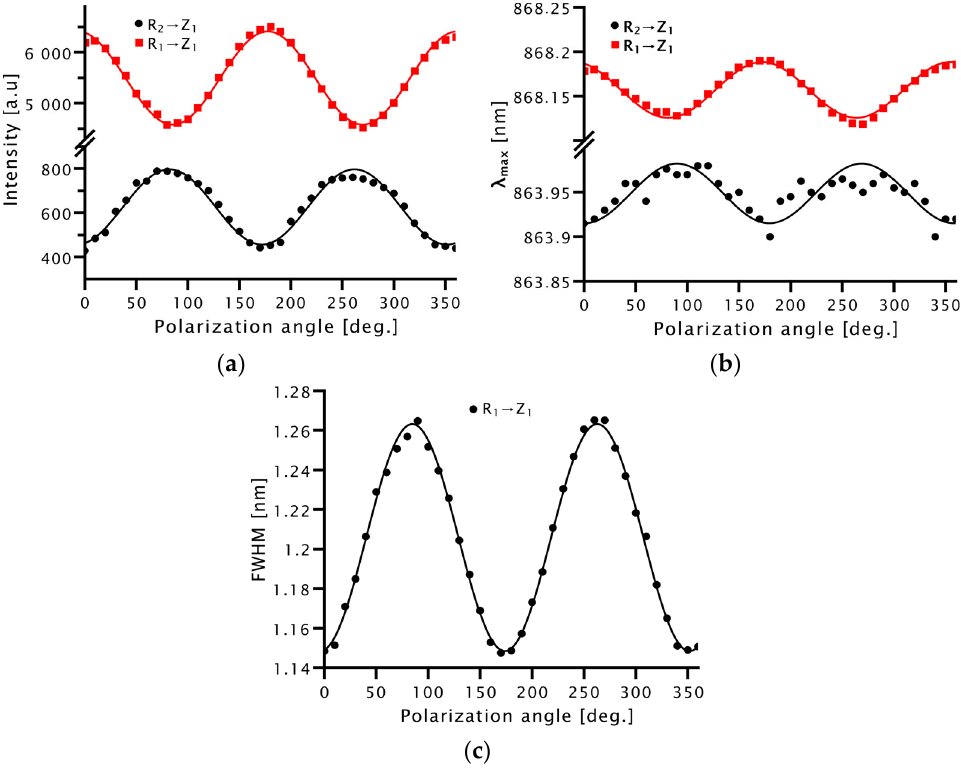
Figure 9. ( a ) Emission intensities of the R 2 → Z 1 and R 1 → Z 1 transition lines of compound [Nd( L3 ) 2 (NO 3 ) 3 ] ( 5 ); ( b ) λ max of the R 2 → Z 1 and R 1 → Z 1 transition lines of 5 ; ( c ) FWHM of the R 1 → Z 1 transition line of 5 as a function of the polarization angle .